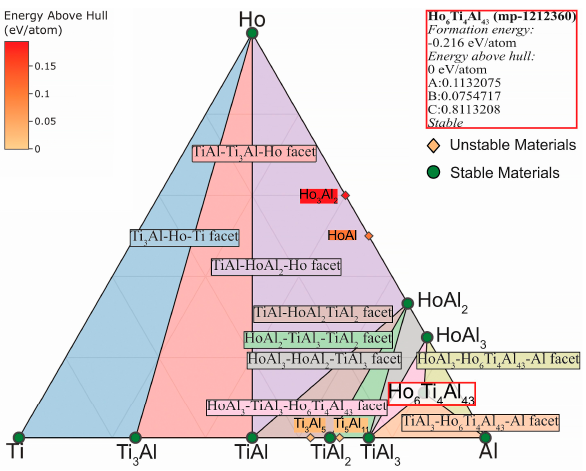
Figure 8. Ti-Al-Ho phase diagram at a temperature of 1150 ° С .